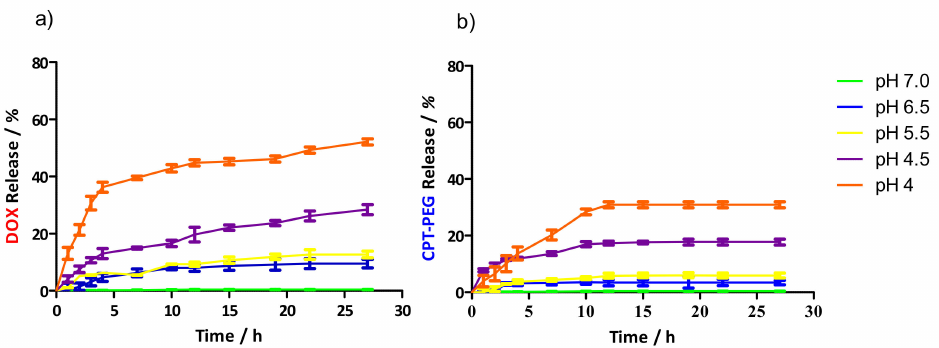
Figure 3. ( a ) DOX and ( b ) CPT-PEG release profile of CPT-PEG@MSN-DOX-GA at di ff erent pH values under stirring at 100 rpm and t = 37 ◦ C. Data represented as mean ± SD ( n = 3).